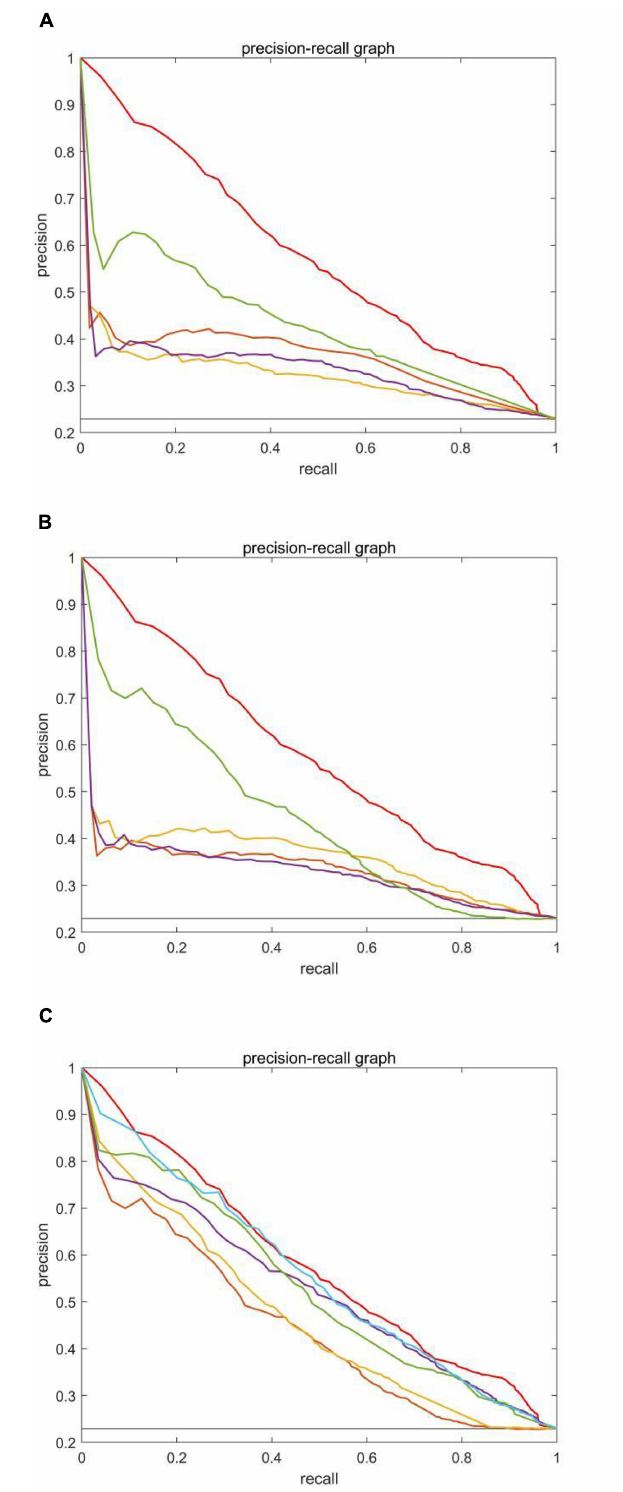
Frontiers in Genetics |